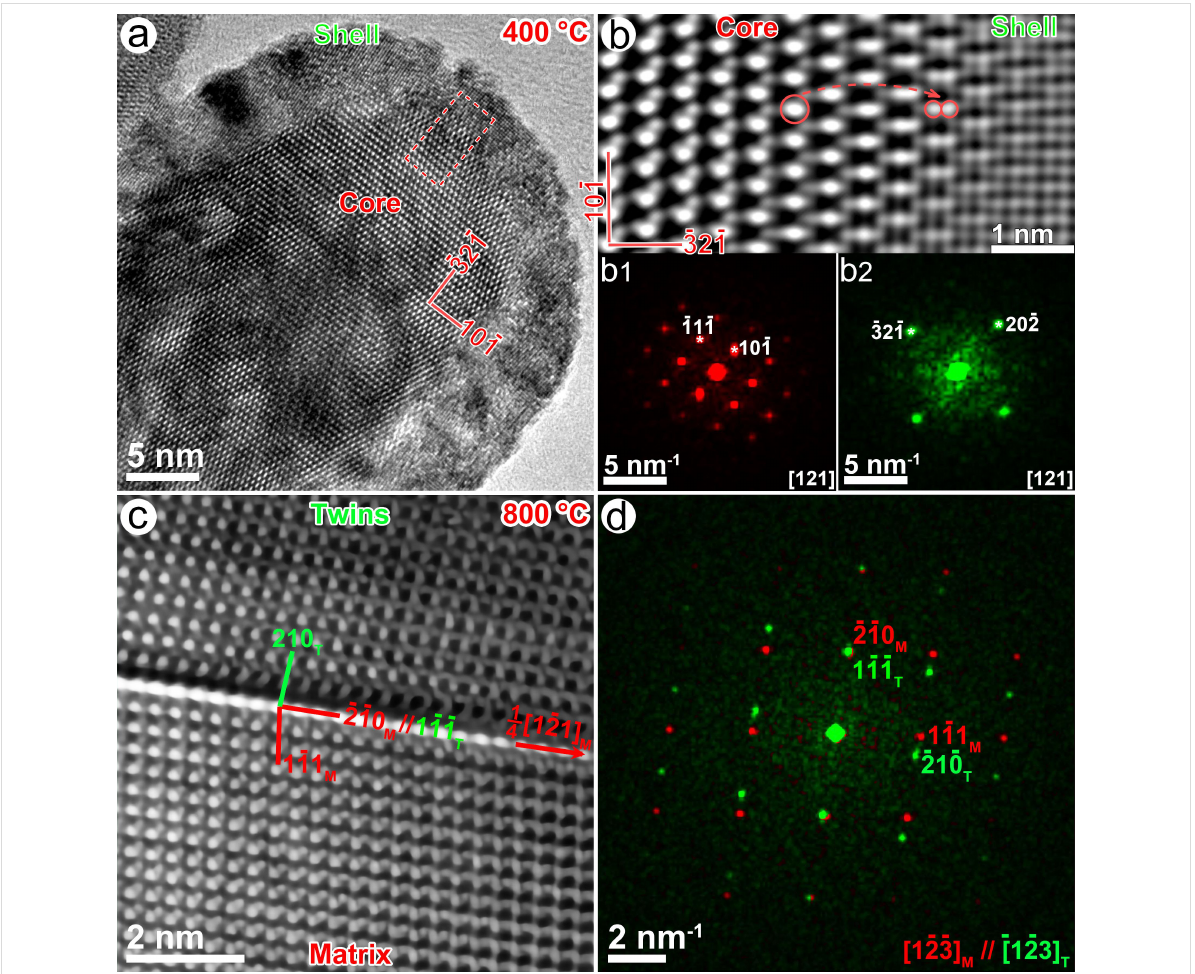
Figure 6: (a) An HRTEM image exhibits the core–shell structure in a brookite crystallite calcinated at 400 °C. (b) The magnified HRTEM image in the dashed box shows an atom-splitting effect. (b1–b2) The Fourier transformation diffractogram of the core and the shell. (c) The HRTEM image of a twinning boundary in a brookite crystallite calcinated at 800 °C, (d) the corresponding Fourier transformation diagram of the matrix (red) and the twins